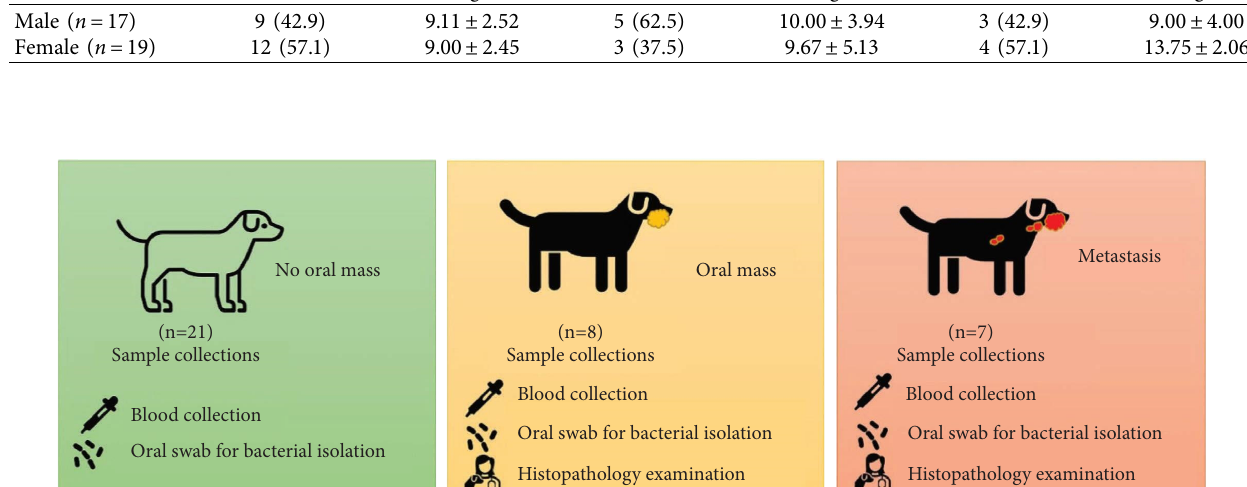
Figure 1: Te groups of animals in this study and techniques of sample collections. Tere was one normal group,the no oral mass group, and the two clinical groups, the oral mass group and the metastasis